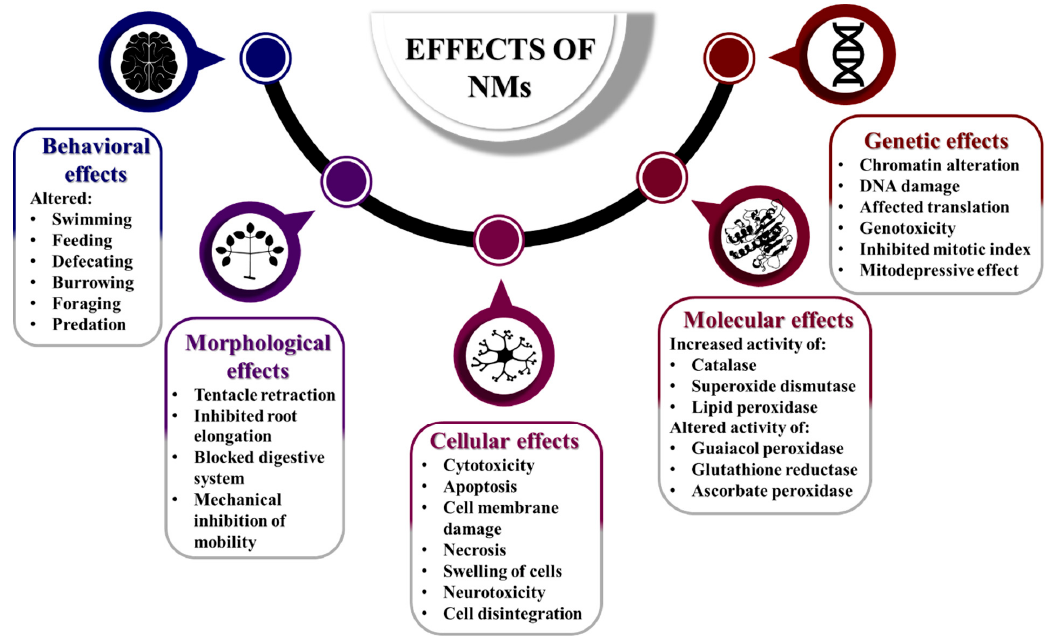
Figure 36. Summary of effects of different categories that NMs can have on different types of organism. The described effects can occur in all or only a few organism types.